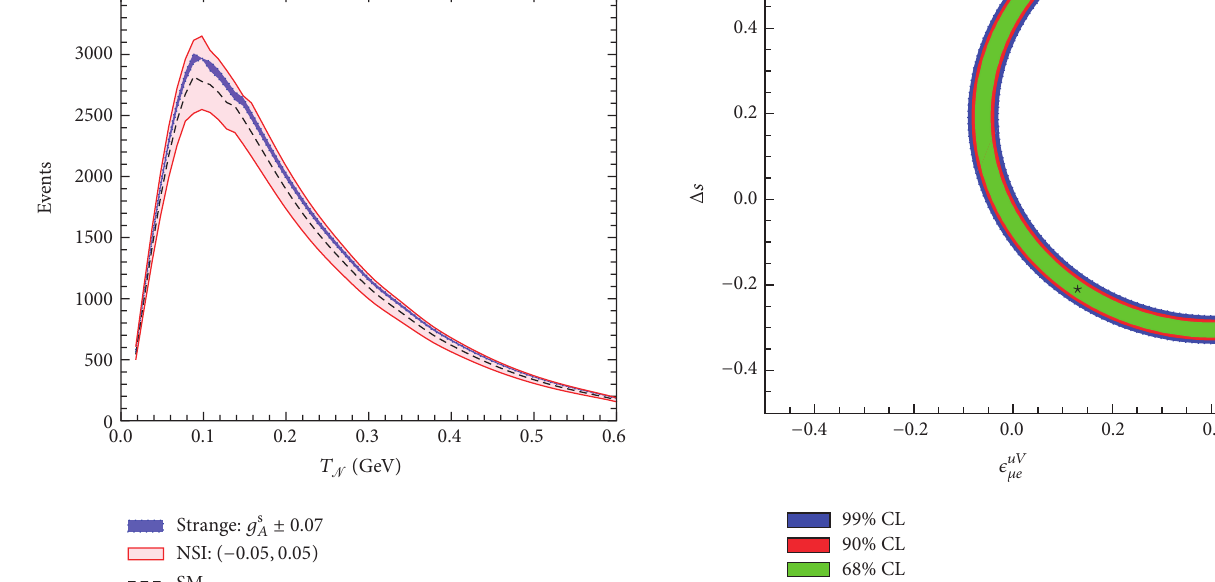
Figure 8: Expected number of events as a function of the nucleon recoil energy 𝑇 N assuming contributions due to the SM, strange quark, and NSI.